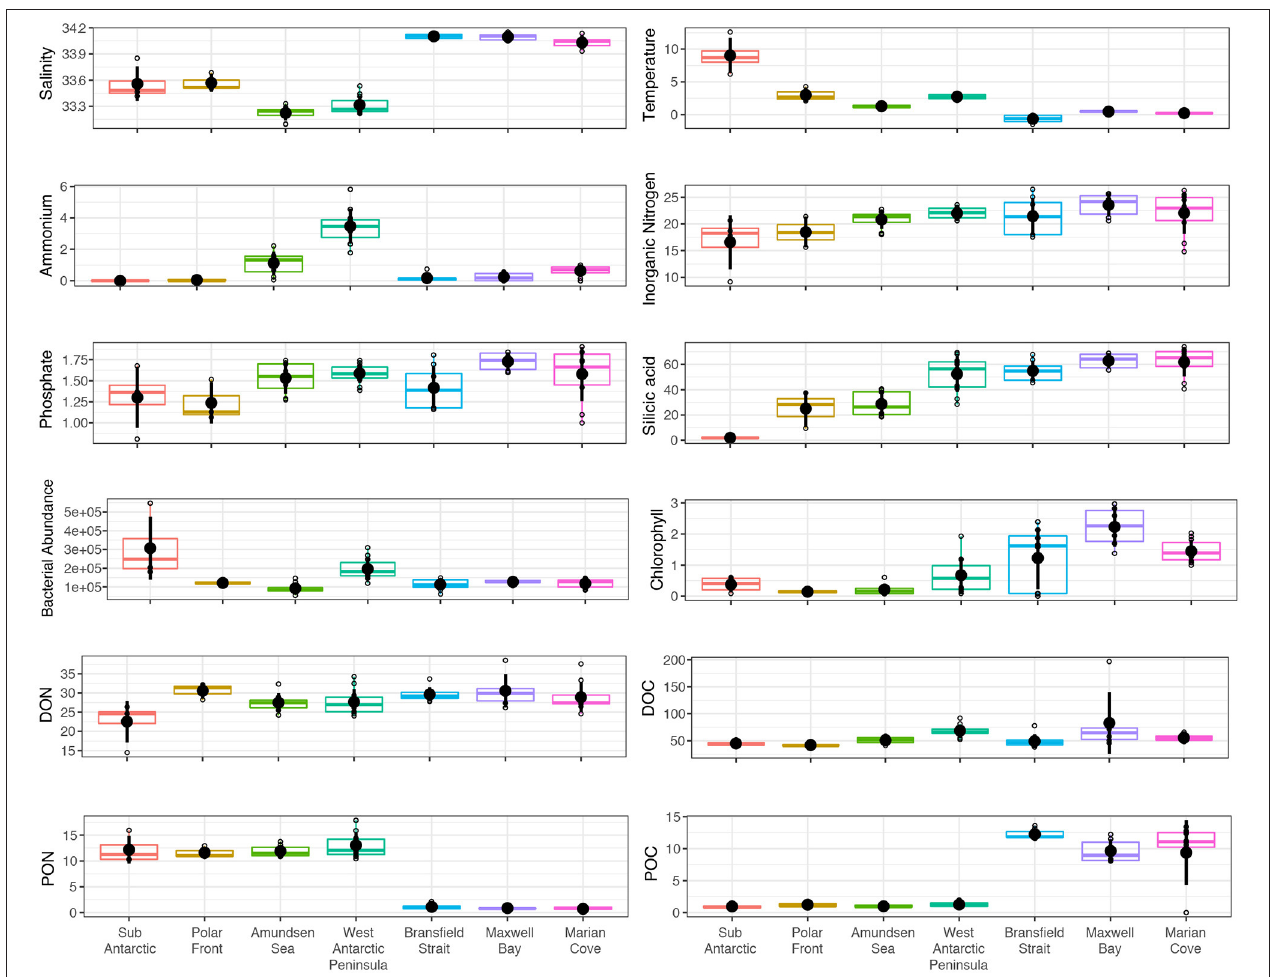
FIGURE 2 | Environmental variables across the seven zones. Variables are ordered from Subantarctic to Marian Cove fjord. For the Bransfield Strait, Maxwell Bay and Marian Cove zones an average of the values corresponding to each variable was used due to multiple depths sampled (0, 10, 25, and 50m). Variables are as